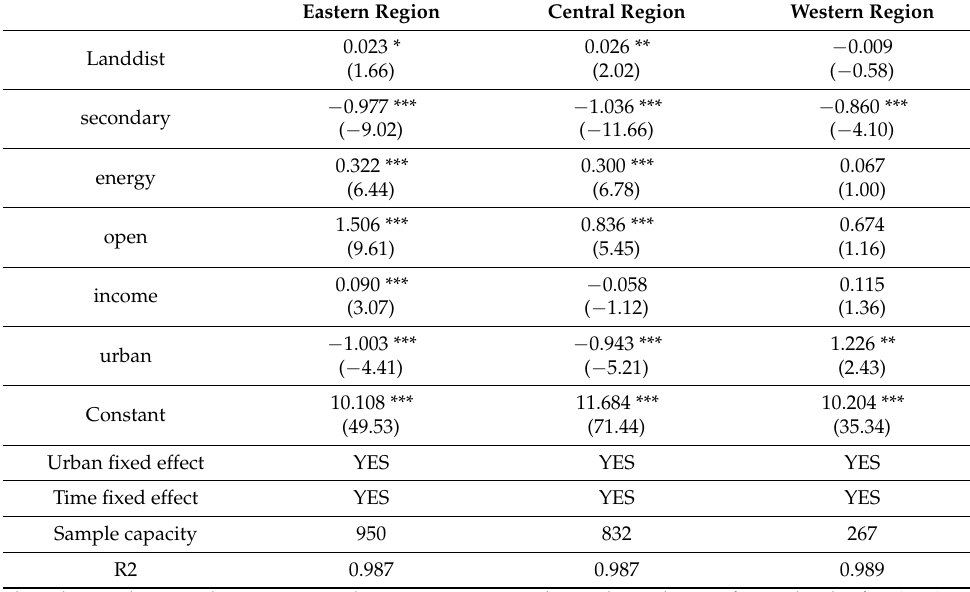
Table 4. Estimated results of the sub-area